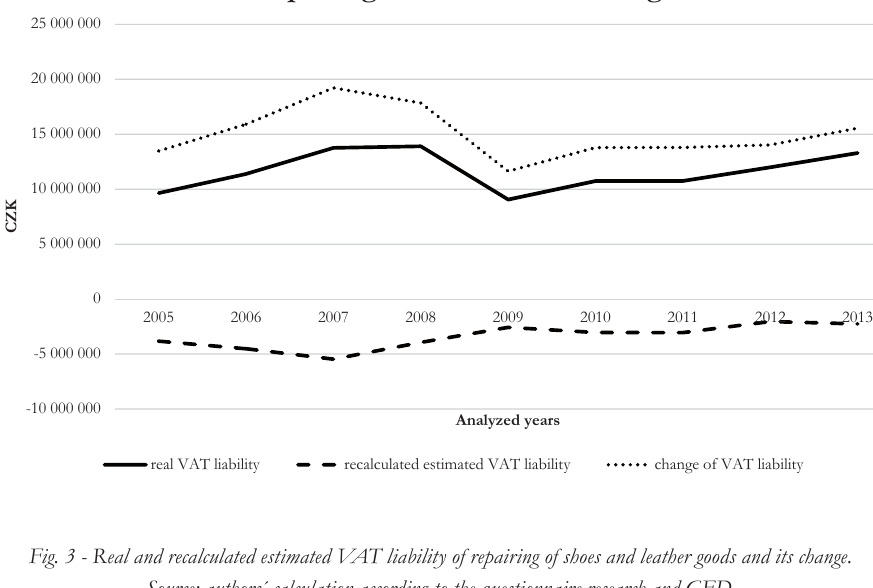
Fig. 3 - Real and recalculated estimated VAT liability of repairing of shoes and leather goods and its change. Source: authors´ calculation according to the questionnaire research and